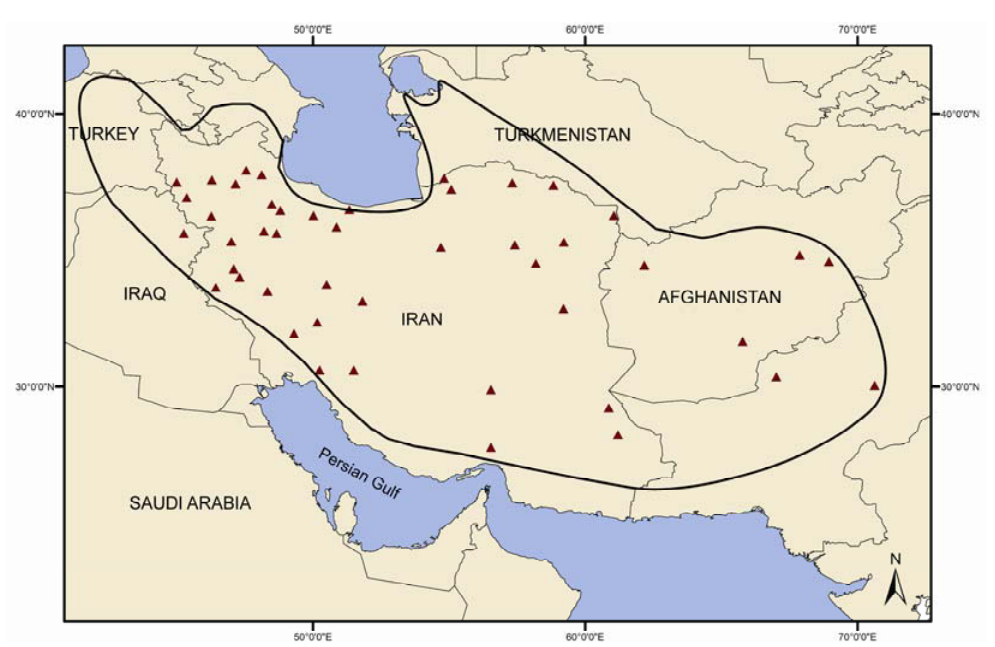
F IGURE 1. Map showing the sampling localities of the Meriones persicus (triangles). The polygon shows the distribution range of the species.